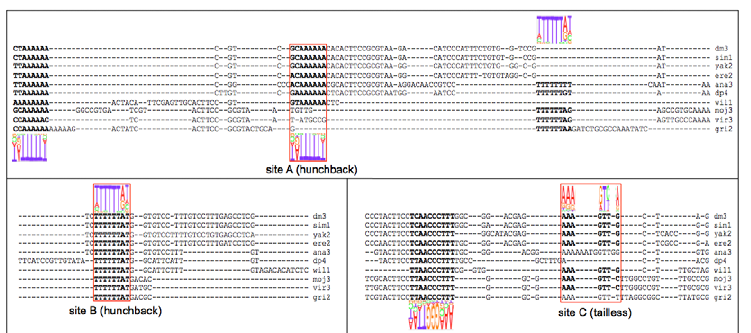
Figure 8. Example MAFIA alignments from the CRM shown in Figure 7. Nucleotides predicted to participate in binding are shown in bold. Weight matrices for factors are shown as sequence logos above (sense strand) or below (antisense strand) the alignment.